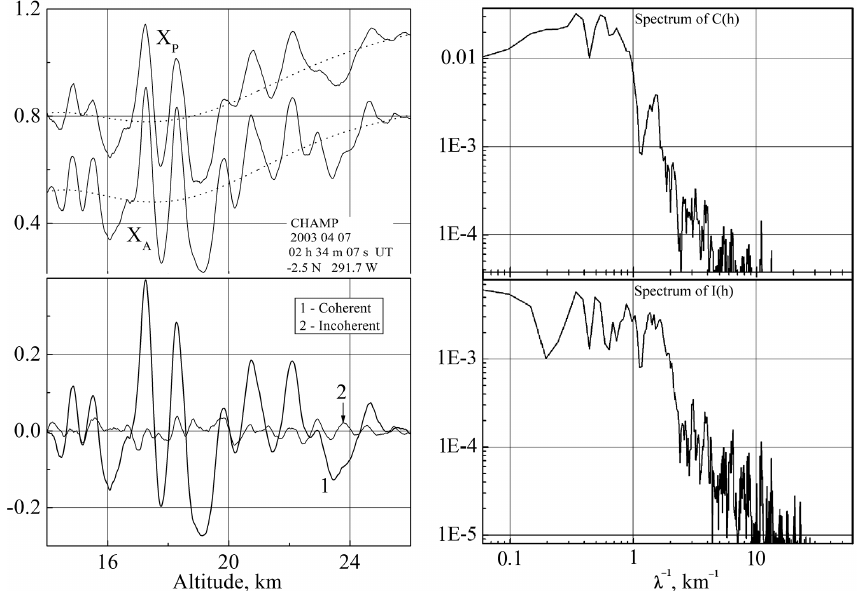
Figure 6. Left, top – Comparison of the refractive attenuations X a (h) , X p (h) found from the RO intensity and eikonal data at GPS fre- quency F1 (curves X A and X P , respectively, displaced for comparison). Dotted curves show the polynomial approximations of the refractive attenuations X a (h) , X p (h) . Left, bottom – Contribution of the atmospheric layers (coherent component of the RO signal) and small scale irregularities (incoherent component) (curves 1 and 2, respectively). Right – Spatial spectra of the coherent and incoherent components of the RO signal (top and bottom panels,